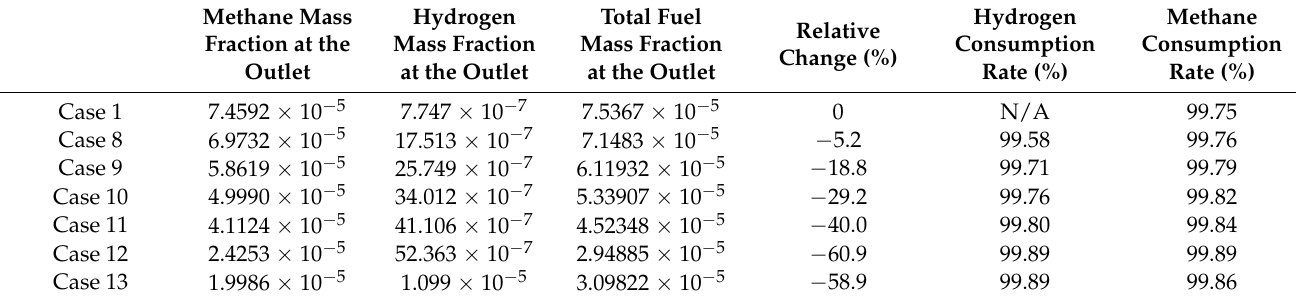
Table 4. The fuel residue at the combustor outlet under constant energy